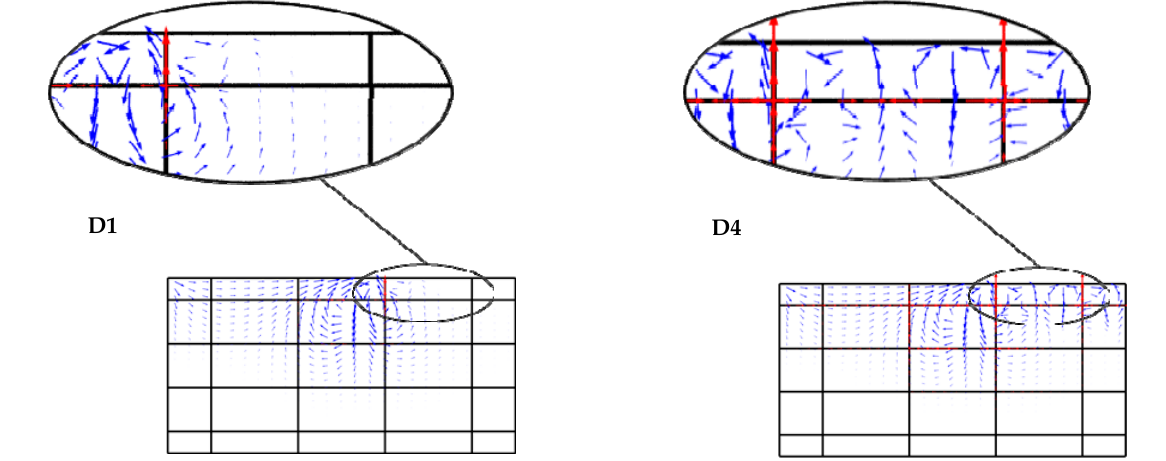
Figure 10. Velocity fields of cases D1 and D4 at simulation time of 1 year. Blue arrows and red arrows represent velocity vectors in porous matrix and fractures, respectively.